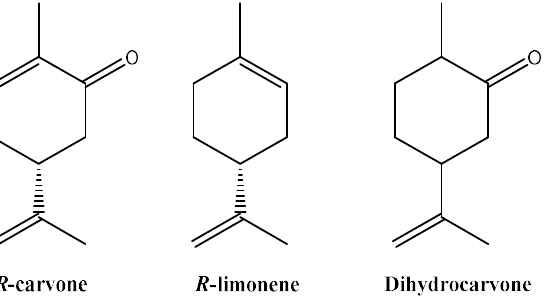
Figure 1. Structures of the main compounds present in EO of A. polystachya . The antioxidant activity of the fresh leaf essential oil of A. polystachya , examined using four different assays, is shown in Table 2. Table 2. Antioxidant activity of essential oil of the fresh leaves of A. polystachya and of three standards, determined by DPPH, H 2 O 2 , FRAP, and TRAP assays. Antioxidant